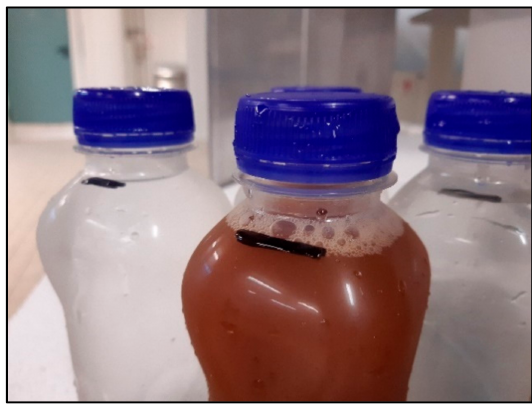
Figure 1. Visual appearance and hermeticity of PLA bottles filled with water and apple juice after subjecting to HPP treatment at 600 MPa for 3 min.